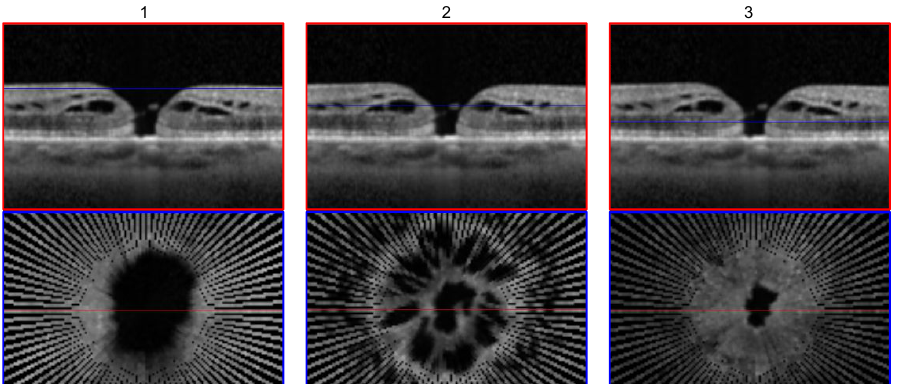
Figure 8. Close-up view of a volumetric reconstructed macular hole surrounding the volumetric center at three different levels (row 1; blue line). Row 2 shows the corresponding top view/coronal height cut to each image in row 1. The levels shown are just below the internal limiting membrane (ILM) in column 1, inner plexiform layer (IPL) in column 2 and at the height of the minimum linear diameter (MLD) in column